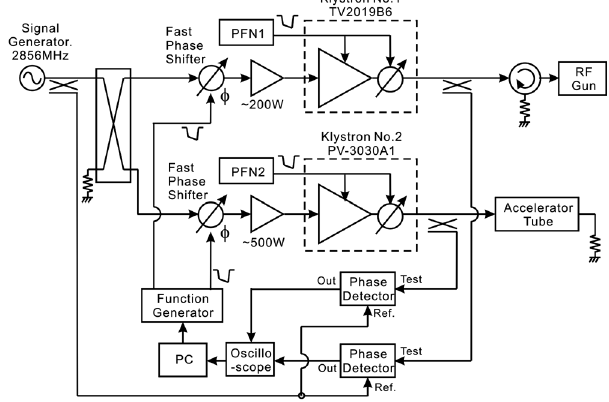
FIG. 3. Schematic diagram of the rf system used to drive the KU-FEL linac. Two fast phase shifters are installed before the klystron driver amplifies.